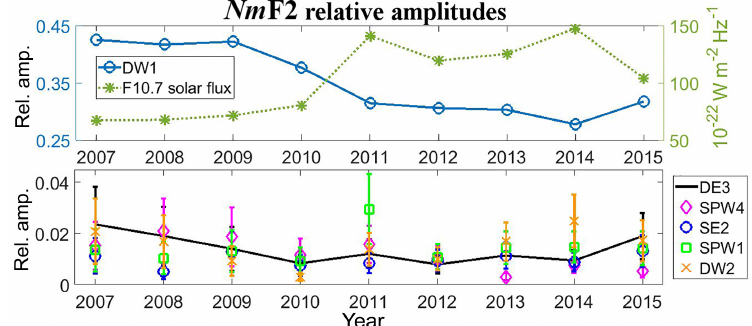
Figure 3. Nm F2 relative amplitudes. Nm F2 relative amplitudes calculated for periods around September equinoxes from 2007 to 2015 for some waves’ signatures observed in Fig. 2, mainly those related to the wave-4 structure, such as SE2, DE3 and SPW4, and those related to the offset between the geographic and geomagnetic coordinates, such as SPW1 and DW2. The F10.7 solar flux is plotted in the top graph, together with the DW1 relative